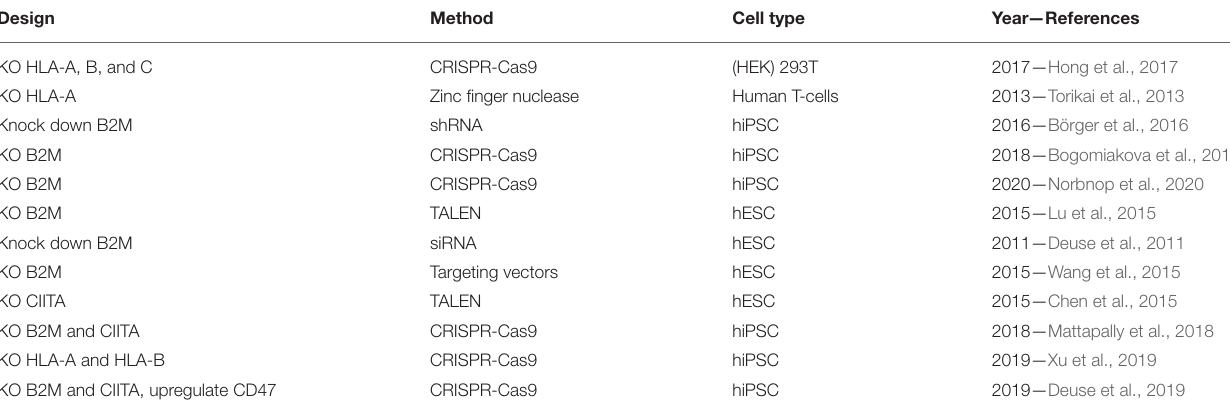
TABLE 1 | List of studies made to generate non-immunogenic